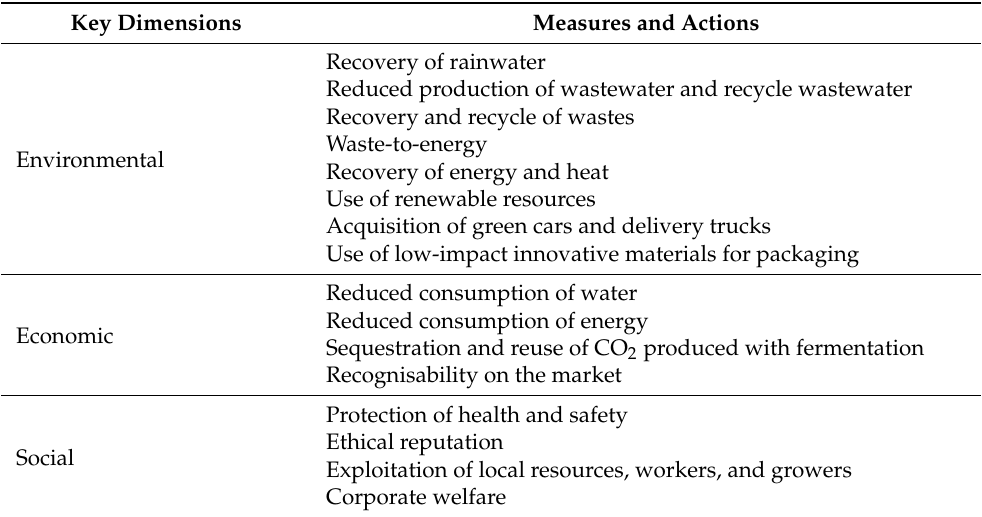
Table 1. Measures related to the three key (environmental, social, economic) dimensions of winery sustainability (our elaboration of information from Moggi et al. and Jeffery [50,51]). Key Dimensions Measures and Actions Recovery of